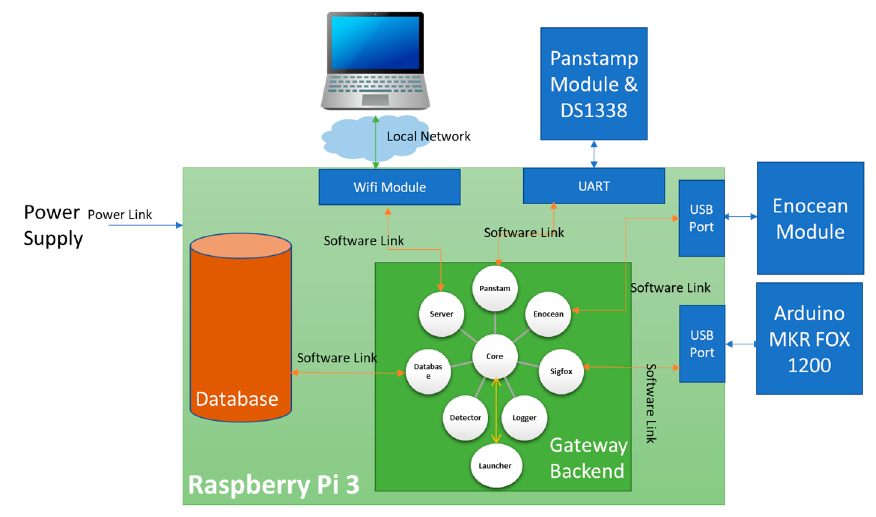
Figure 20. The gateway software and hardware components..